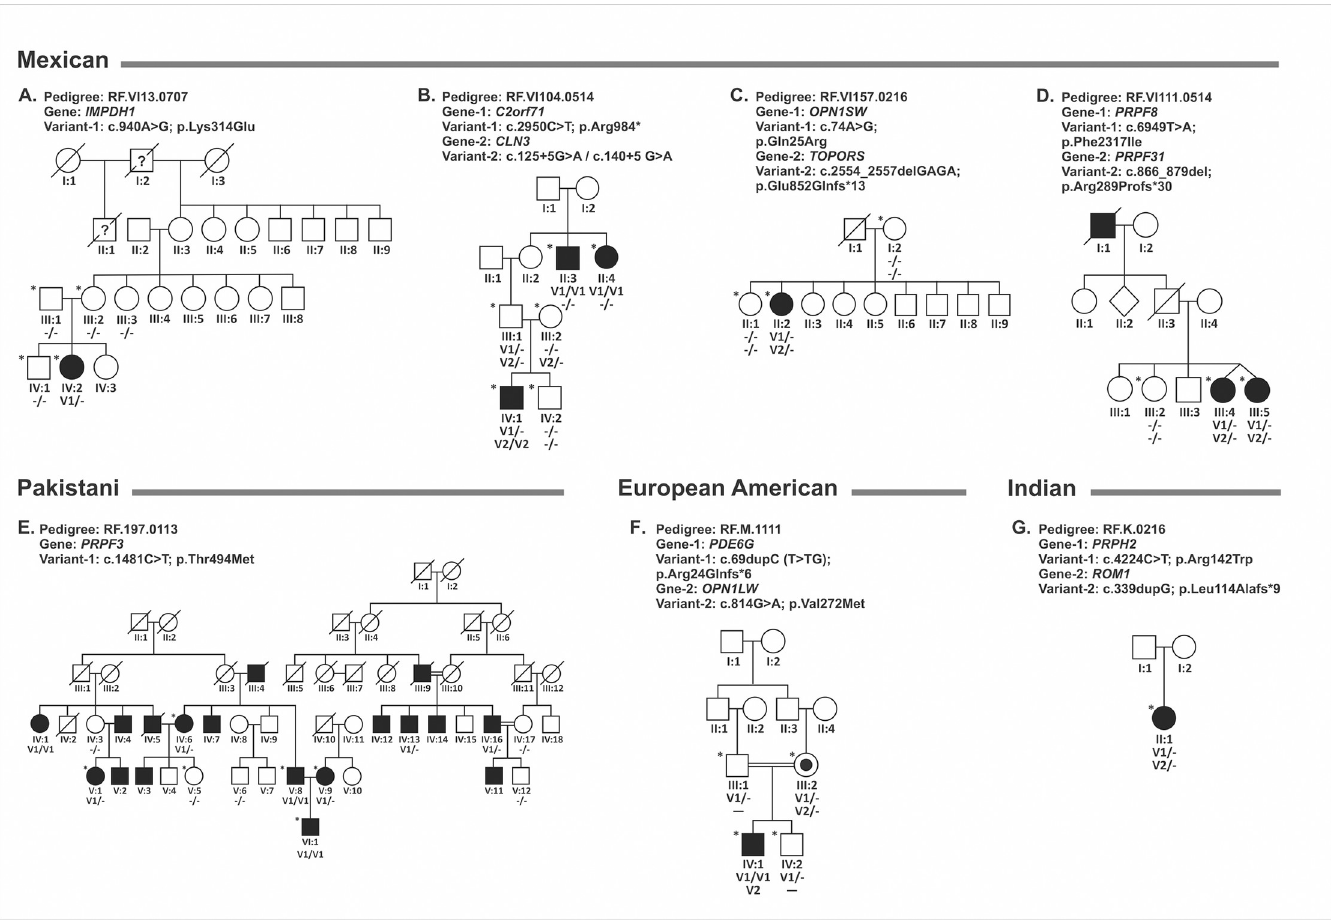
Fig 4. Segregation analysis of pedigrees with atypical genotypes. A-D: Mexican pedigrees with atypical mutations. A. RF.VI13.0707 pedigree with a de-novo mutation in IMPDH1 ; B. RF.VI104.0514 pedigree with a homozygous nonsense mutation in C2orf71 was detected in generation II while a previously reported homozygous splice site mutation in the CLN3 gene was observed in proband in the IV generation demonstrating the involvement of two different genes in IRD pathology in different generations. C. RF.VI157.0216 pedigree with mutations in genes OPN1SW and TOPORS associated with dominant color blindness and retinitis pigmentosa; D. RF. VI111.0514 pedigree with novel heterozygous causative mutation in PRPF8 and a known mutation in PRPF31 , each sufficient to cause dominant IRD, were observed in monozygotic affected twins; E. RF.197.0113 consanguineous pedigree from Pakistan with a previously known dominant acting mutation in PRPF3 segregated in a pseudo-recessive pattern; F . RF.M.1111 an European American pedigrees with causative variants in more than one known IRD genes were observed to segregate with disease. A homozygous mutation in PDE6G and a hemizygous mutation in OPN1LW were observed in Pedigree RF.M.1111. G. RF.K.0216 Indian pedigree with a heterozygous PRPH2 mutation that is sufficient to cause retinal dystrophy and an additional mutation in ROM1 that can lead to digenic RP along with the PRPH2 variant. The asterisk indicates the availability of whole-genome sequencing data.